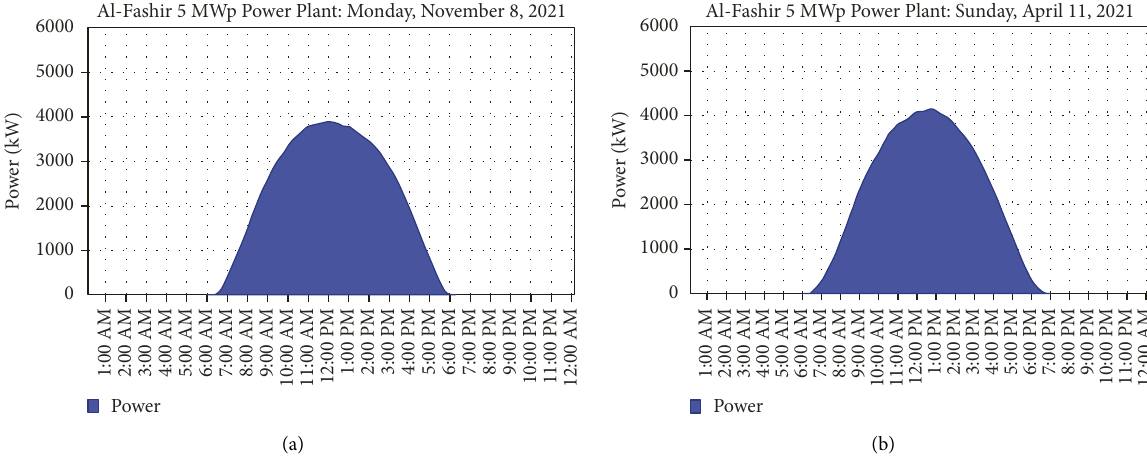
Figure 20: Plant recorded output power. (a) April. (b) 8 November.